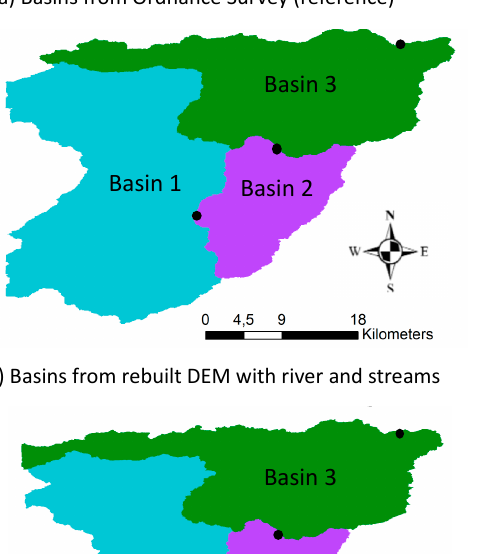
a) Basins from Ordnance Survey (reference) b) Basins from SRTM30